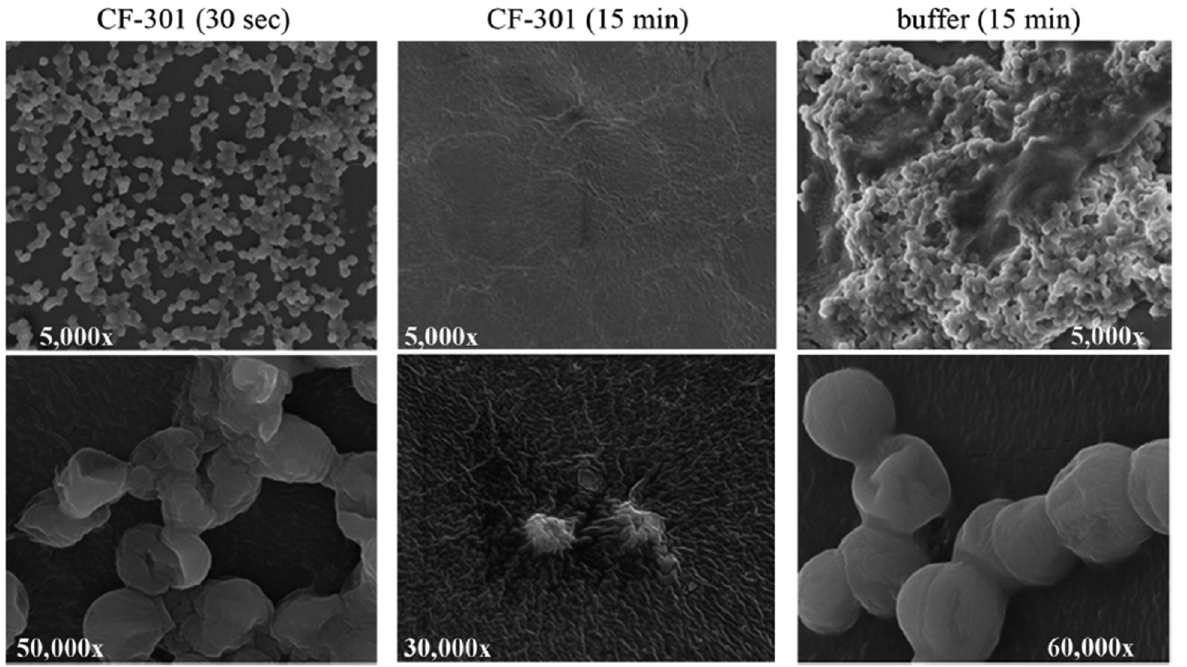
Figure 3: MRSA strain ATCC BAA - 42 bio fi lms developed for 3 days in the catheter lumen against CF - 301 [ 46 ]